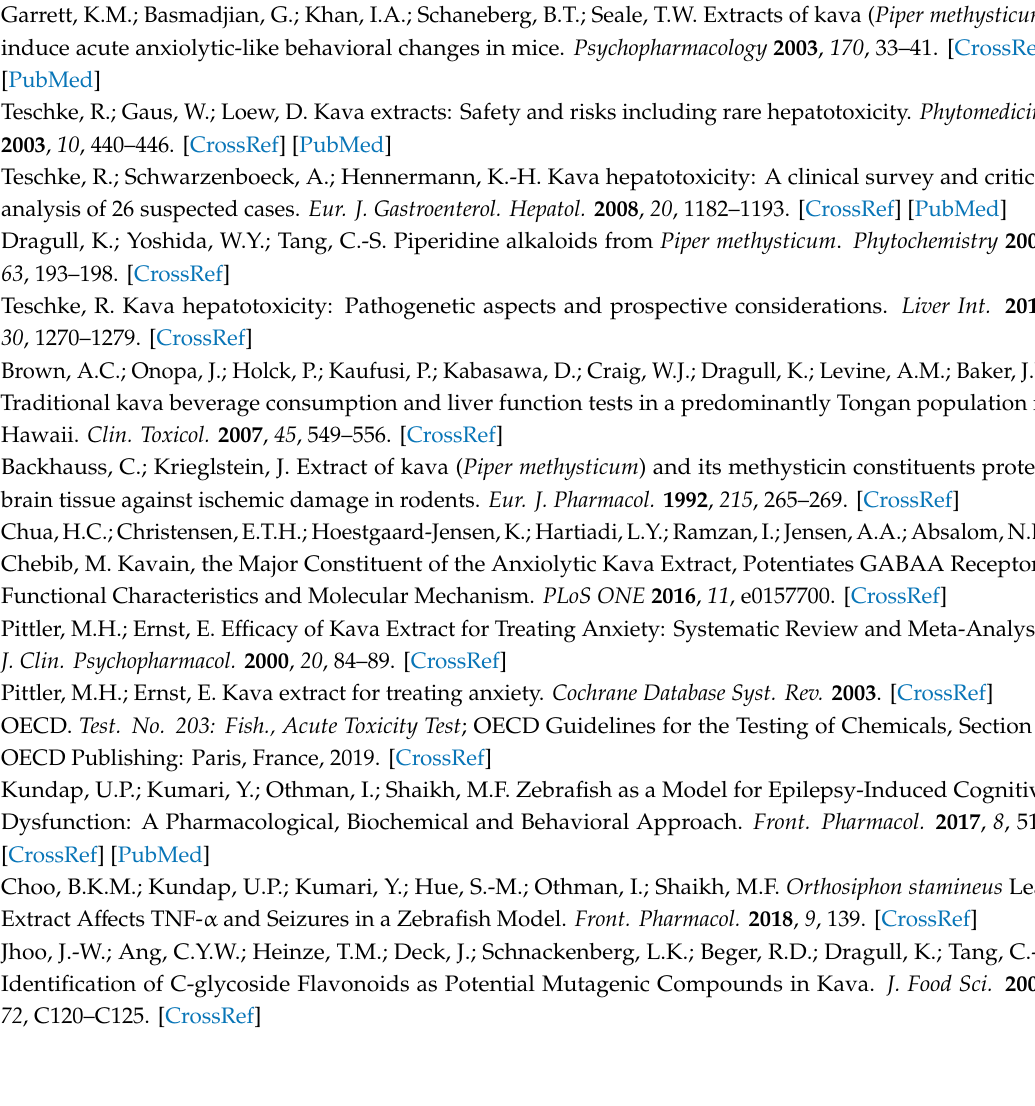
e ff ects of diazepam in terms of seizure intensity and onset time. The expression of BDNF